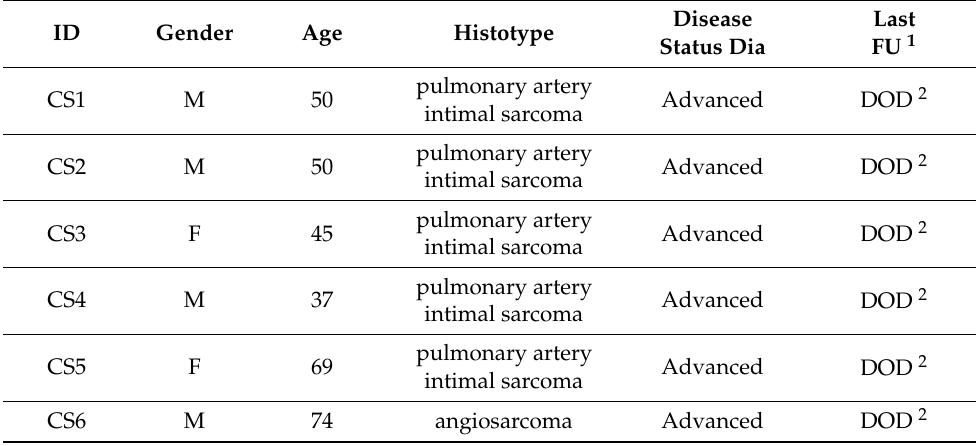
Table 1. Classification of our subset of patients (n = 11) diagnosed with primary cardiac